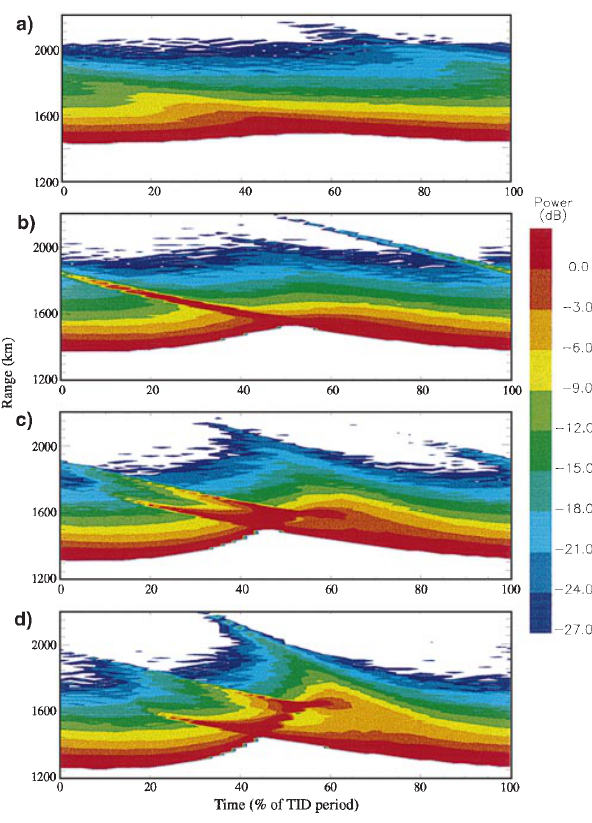
Fig. 5a–d. As for Fig. 4, except for a radar frequency of 12.4 MHz